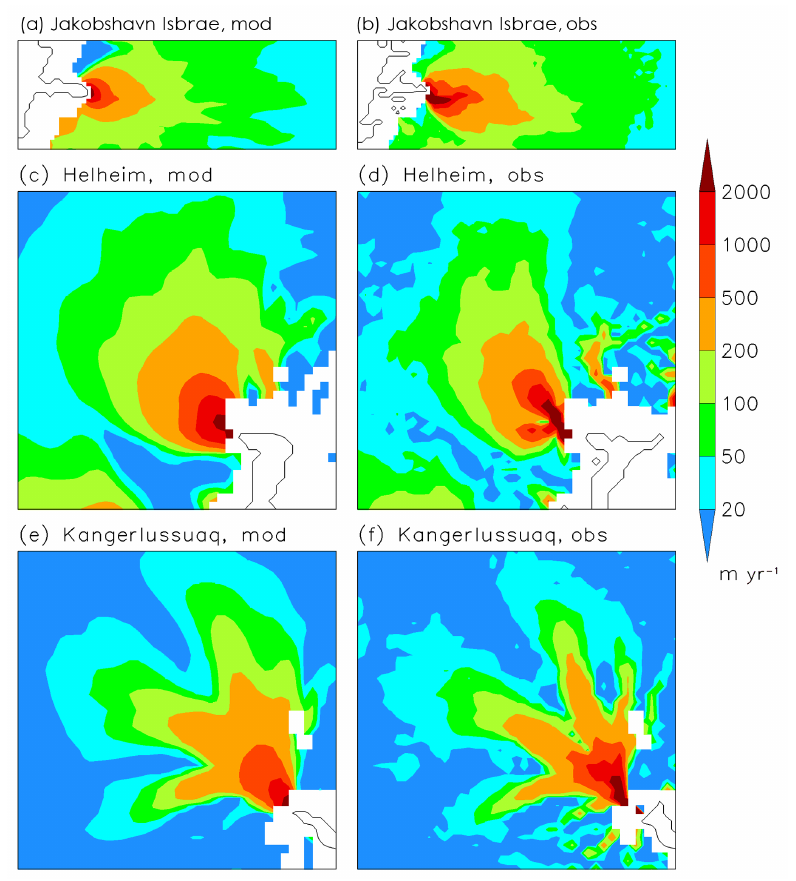
Figure 8. Comparison of simulated and observed (Rignot and Mouginot, 2012) velocity for major ice streams and outlet glaciers. Left side: modelled, right side: observed. (a, b) Jakobshavn Isbræ, (c, d) Helheim Glacier, and (e, f) Kangerlussuaq Glacier. The location of the three regions in Greenland is shown in Fig.